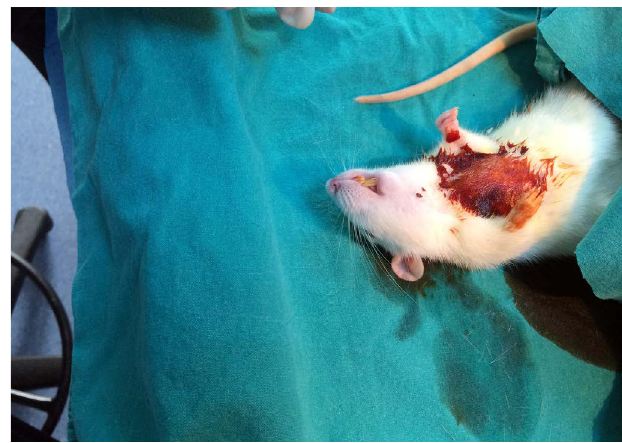
Fig. 1 - Mediastinal appearance before sternotomy.